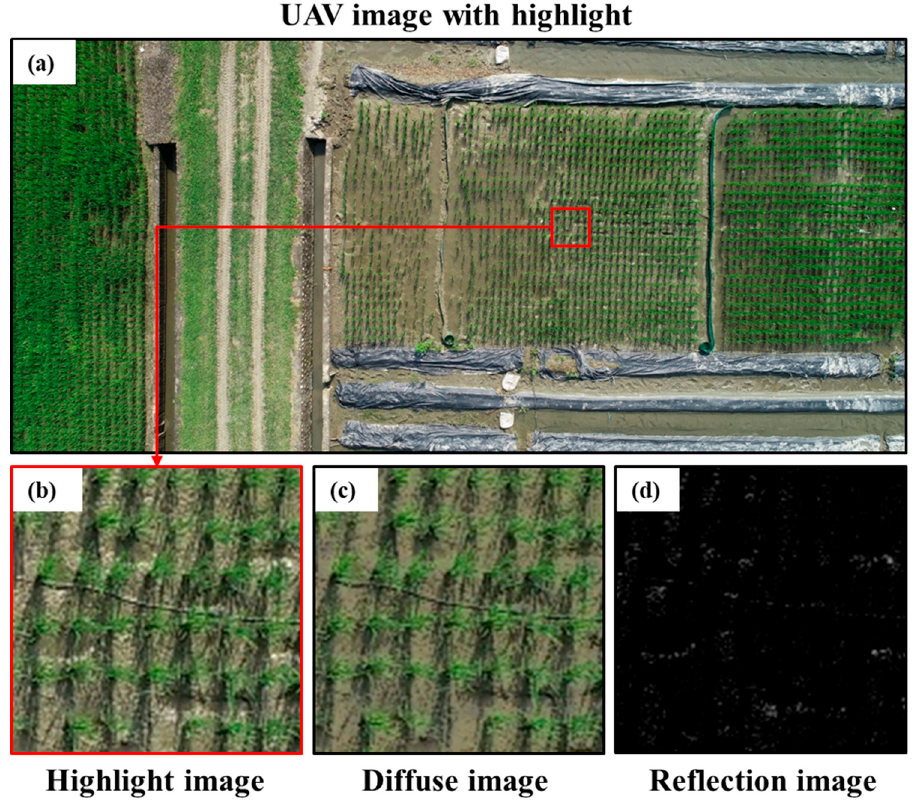
Figure 5. ( a ) Original UAV image; ( b ) highlight image; ( c ) diffuse image; and ( d ) reflection image.